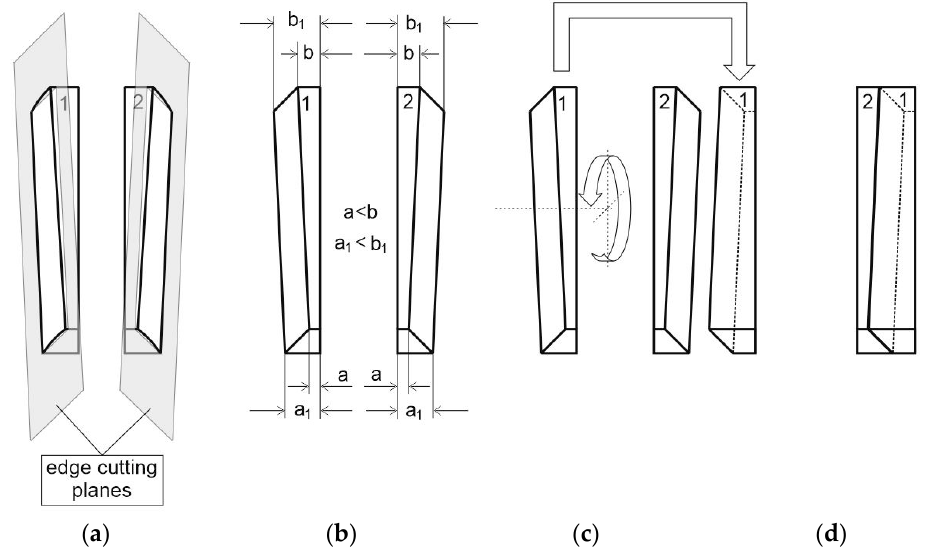
Figure 3. Reconstituted board obtained by edge-cutting at 45°, double (anti-parallel) rotation and gluing of mirrored tapered sideboards from the same log: ( a )—45 ° edging of timber pieces 1 and 2; ( b )—timber pieces 1 and 2 after 45 ° edging; ( c )—rotation at 180 ° of piece 1, upside-down and front to back; ( d )—joining pieces 1 and 2 in “anti-parallel” position by gluing and pressing.